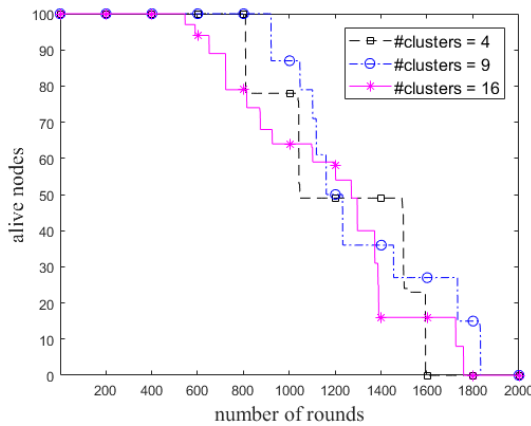
Figure 8. Number of alive nodes in each round in ECCR.